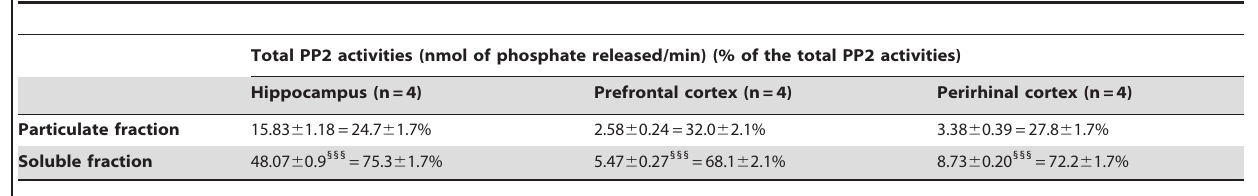
Table 4. Distribution of the total PP2 activities between particulate and soluble fractions from rat hippocampus, prefrontal cortex and perirhinal